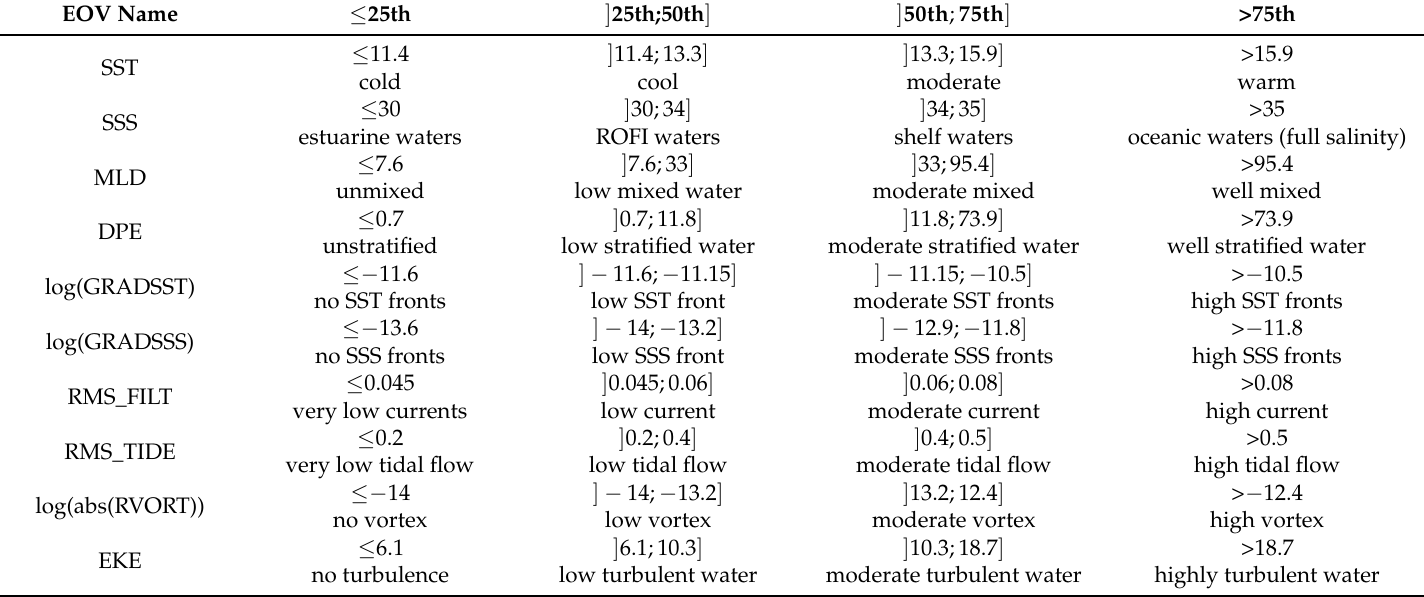
Table 3. The 25th, 50th and 75th range of variability of EOVs distribution on the whole area, except for salinity, and associated